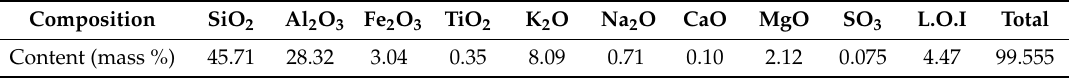
Table 1. Chemical composition of the original